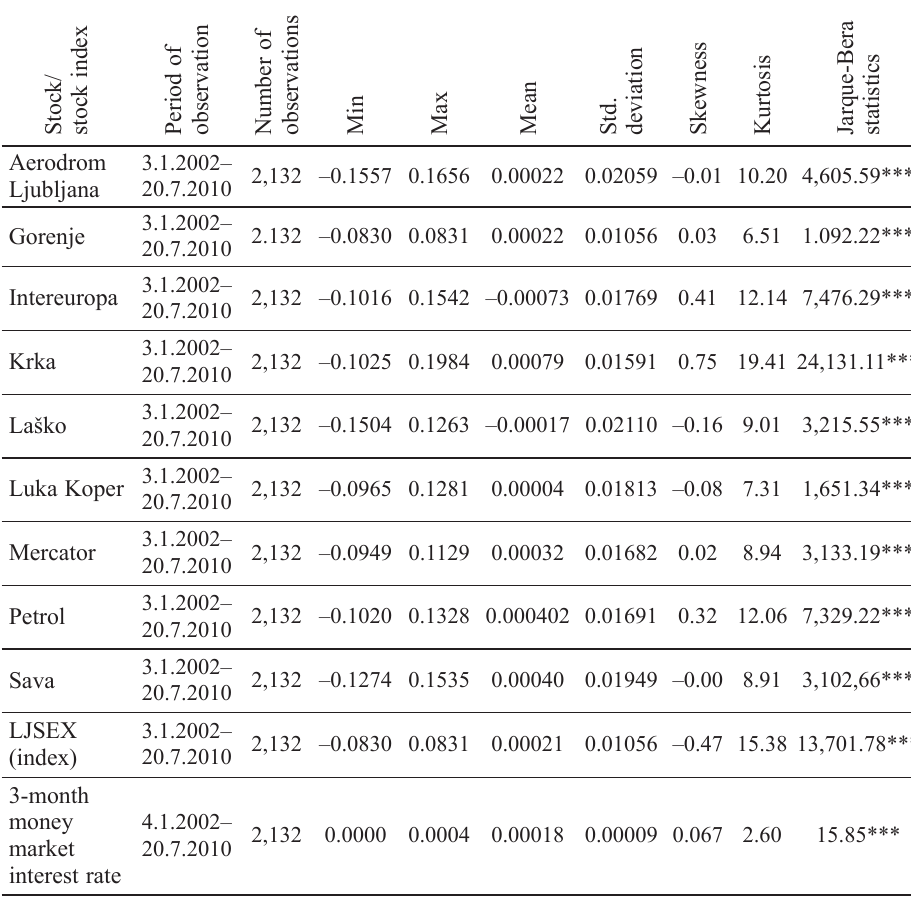
Table 1. Descriptive statistics for returns series of stocks listed at Slovenian stock exchange and its representative national stock